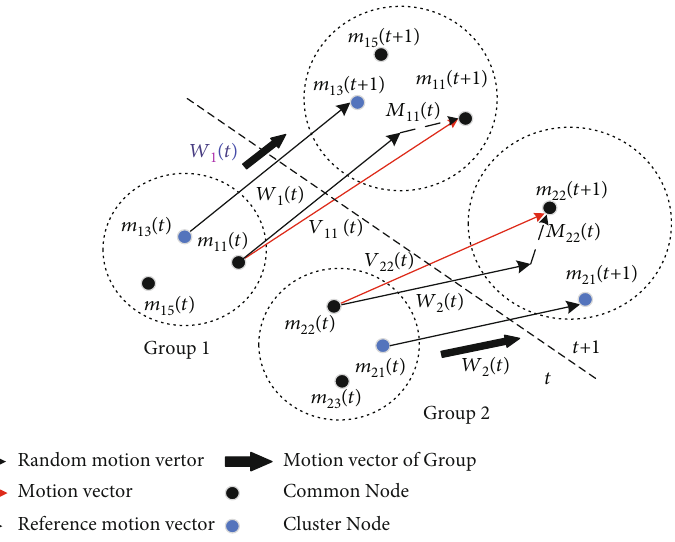
Figure 7: Schematic diagram of